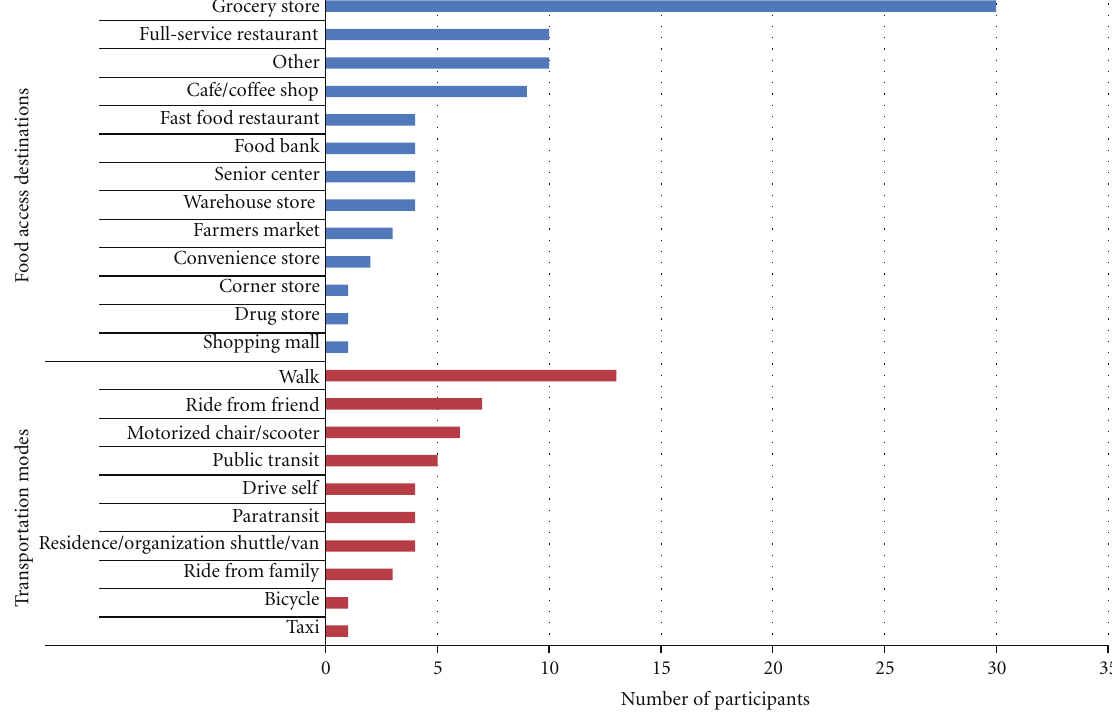
Figure 1: Counts of food access destinations and transportation modes used by study